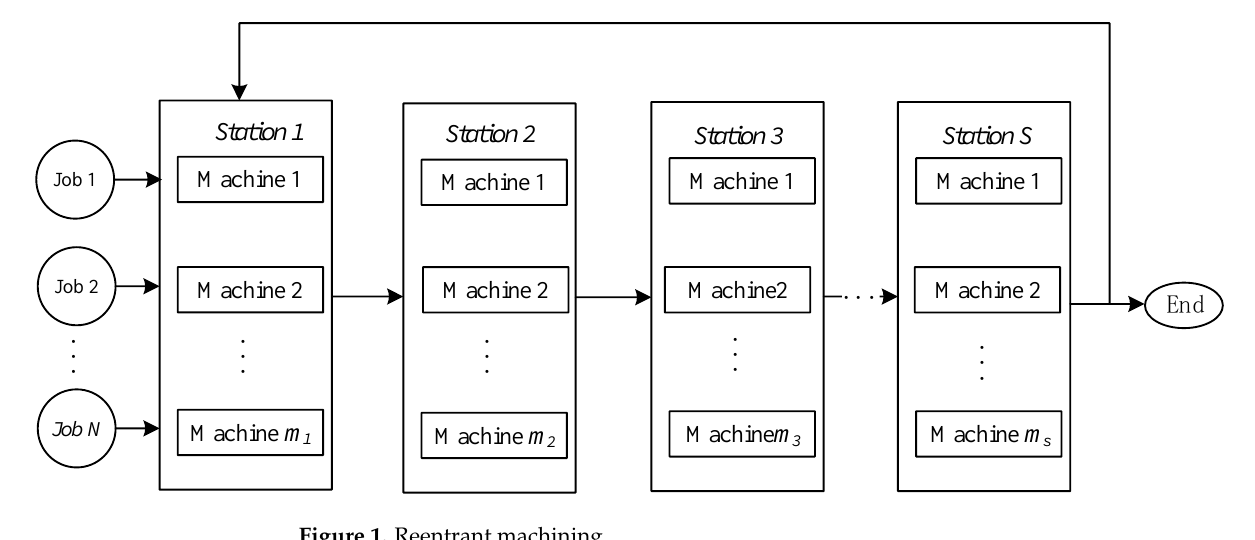
Figure 1. Reentrant machining.